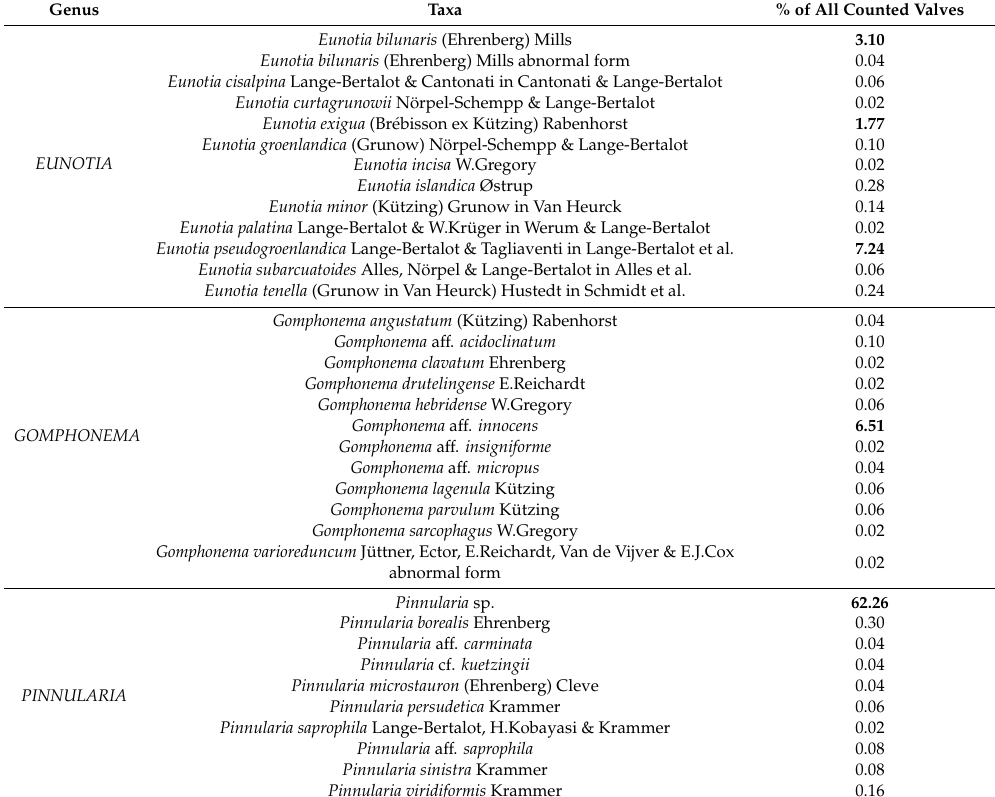
Table 3. Dominant genera and the species associated and their percentage considering all counted valves (in bold: the highest percentages >